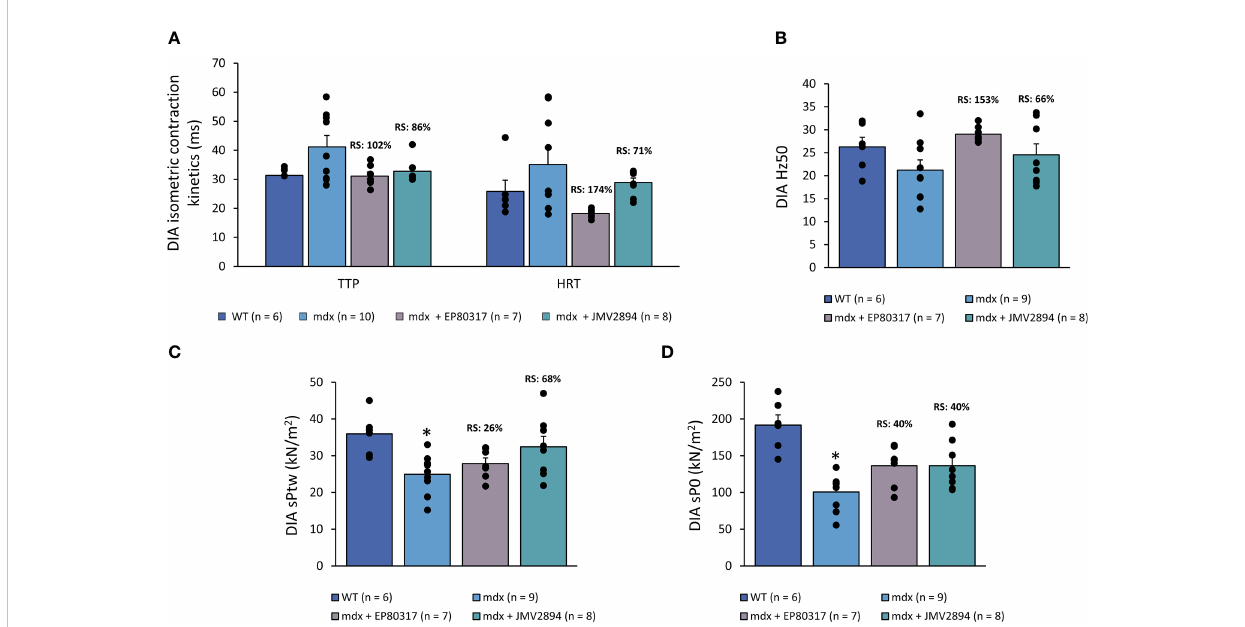
FIGURE 3 Isometric twitch contraction kinetics (time to peak, TTP, and half-relaxation time, HRT, ms; A ), Hz50 ( i.e. the frequency at which 50% of maximal isometric speci fi c tetanic force is produced; B ), maximal speci fi c isometric twitch (sPtw, kN/m 2 ; C ) and tetanic (sP0, kN/m 2 ; D ) forces. Values are expressed as mean ± SEM from the number (n) of mice indicated in brackets. A statistically signi fi cant difference among groups was found by one- way ANOVA for TTP and HRT (F > 3.3, p < 0.04), sPtw (F = 4.7, p < 0.01), and sP0 (F = 11.6, p < 0.0001). Bonferroni post-hoc test for individual differences between groups is as follows: * vs. WT (0.001 < p < 0.05). Recovery scores (RS) toward WT values are indicated above the